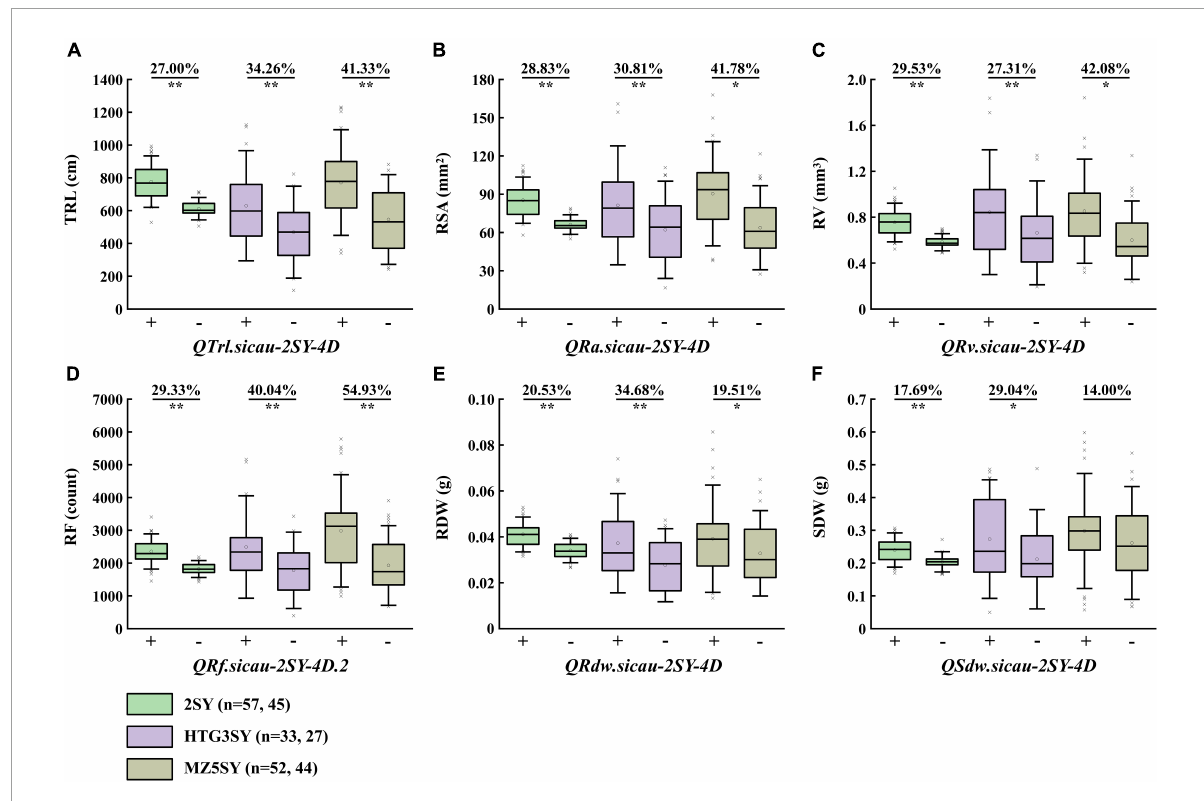
FIGURE4 Effects of QTrl.sicau-2SY-4D (A) , QRsa.sicau-2SY-4D (B) , QRv.sicau-2SY-4D (C) , QRf.sicau-2SY-4D.2 (D) , QRdw.sicau-2SY-4D (E) , and QSdw.sicau-2SY-4D (F) in 20828/SY95-71 (2SY), HTGW3/SY95-71 (HTG3SY), and MZ5-2/SY95-71 (MZ5SY) populations, respectively. + and - represent lines with and without the positive alleles of the corresponding QTL. * and ** mean significant difference at P < 0.05 and 0.01 probability